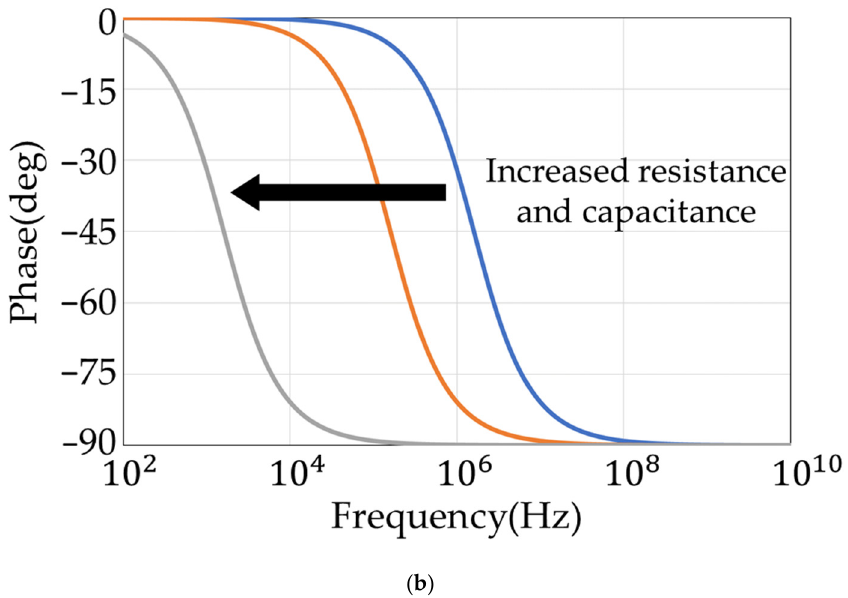
Figure 3. Frequency response of the R and C parallel circuit. ( a ) Absolute impedance. ( b ) Phase.